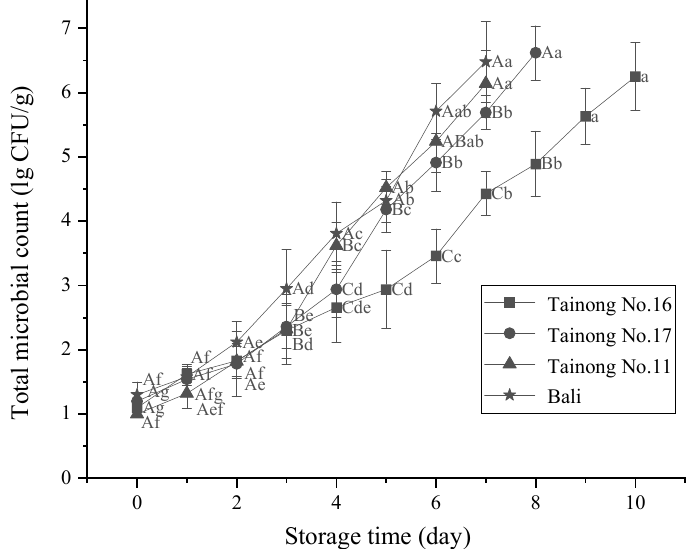
Figure 7. Changes in the total number of microorganisms in freshly cut pineapple during storage. Different capital letters (A–C) indicate significant ( p < 0.05) differences in the total number of microorganisms between varieties at the same storage time; different lowercase letters (a–g) indicate significant ( p < 0.05) differences in the total number of microorganisms between the same varieties at different storage times.